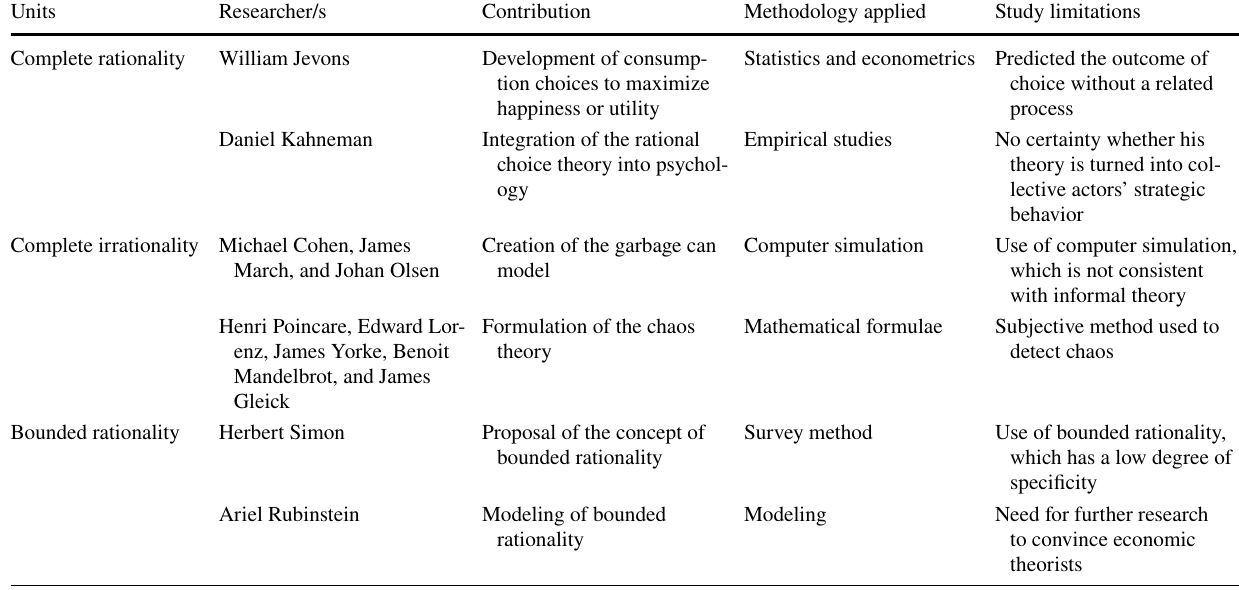
Table 1 Summary of major previous studies on decision-making